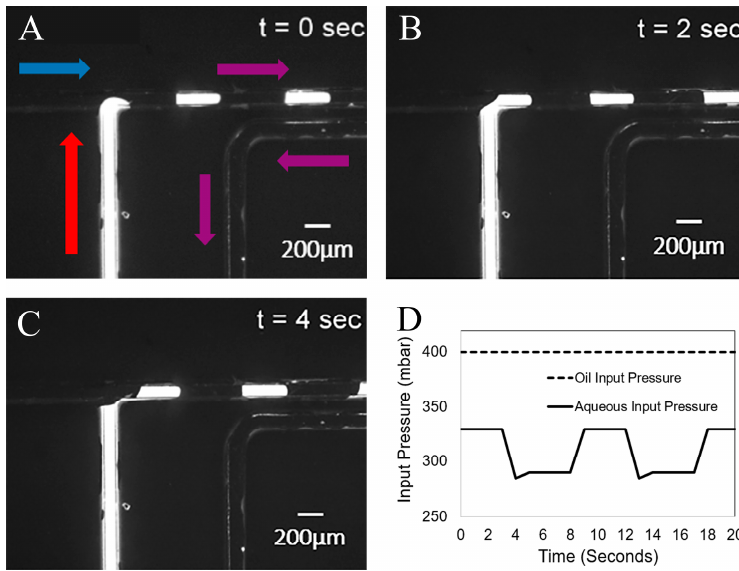
Figure 2. Time step of the creation of rhodamine-solution (red arrow) droplets in oil (blue arrow) at a T-Junction of ( A ) 0 s, ( B ) 2 s, and ( C ) 4 s. Flow direction is indicated by the arrows. ( D ) Plot of input pressures versus time, output, and membrane ports at to atmosphere.